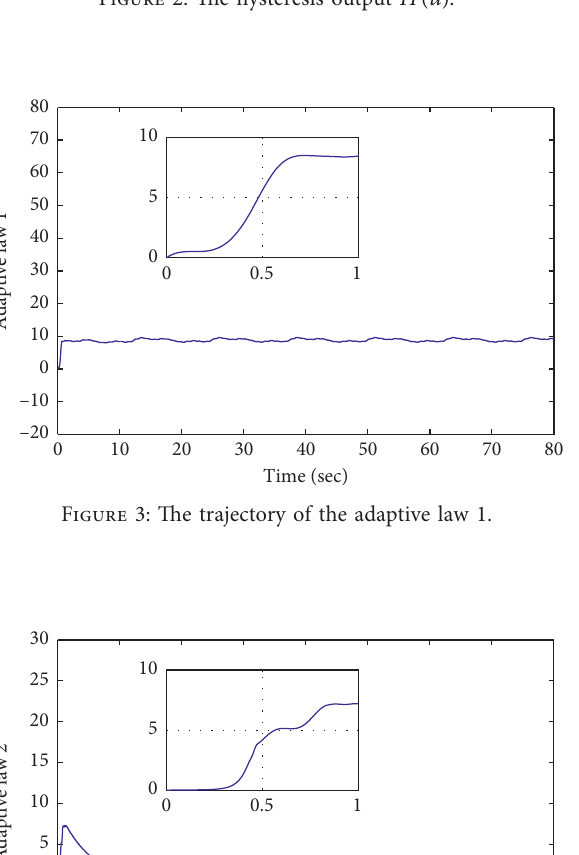
Figure 2: The hysteresis output H ( u ) .